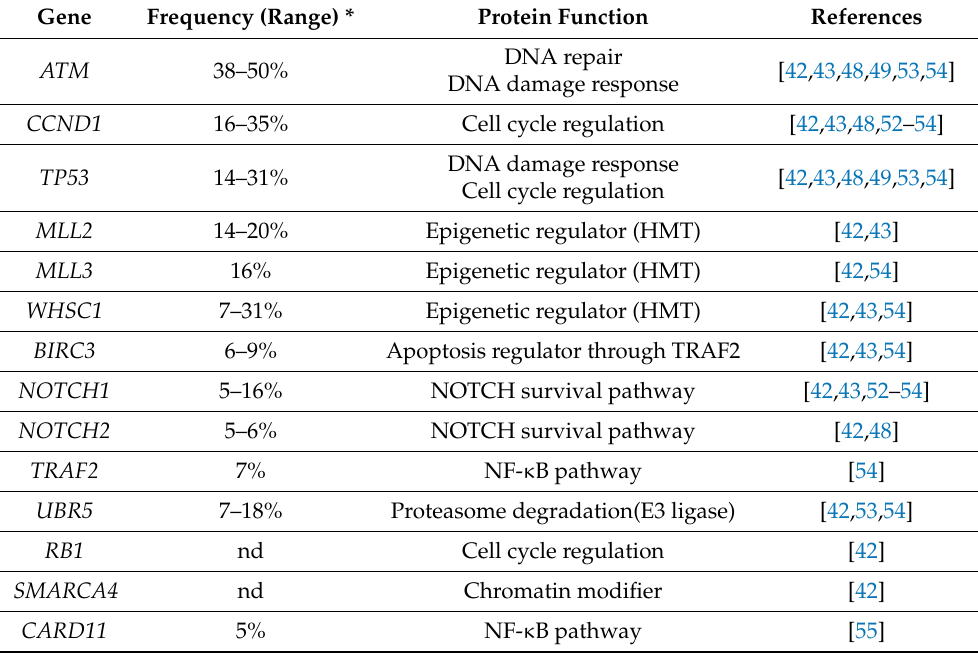
Table 1. Recurrent genomic alterations described for MCL patients and cell